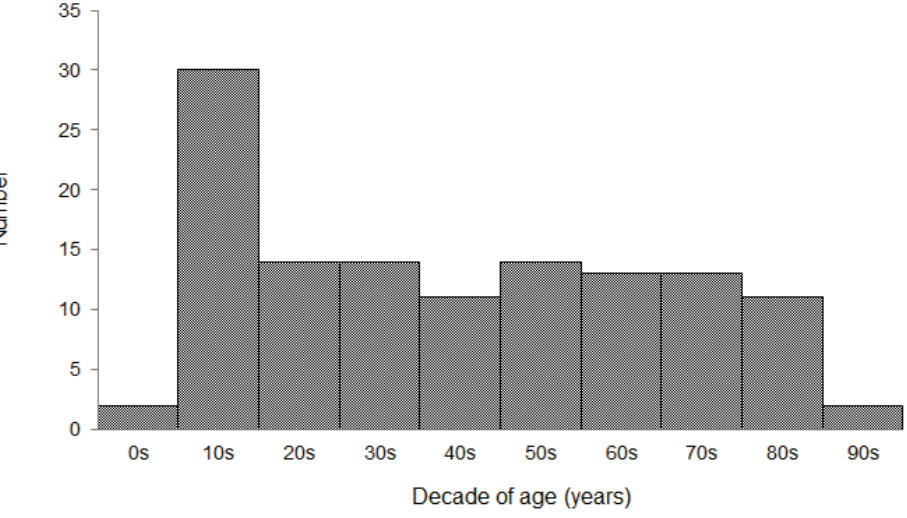
Figure 1. Ages of patients who presented with heat illness at the emergency department. Patient age ranged from five to 95 years, with teenagers presenting the most